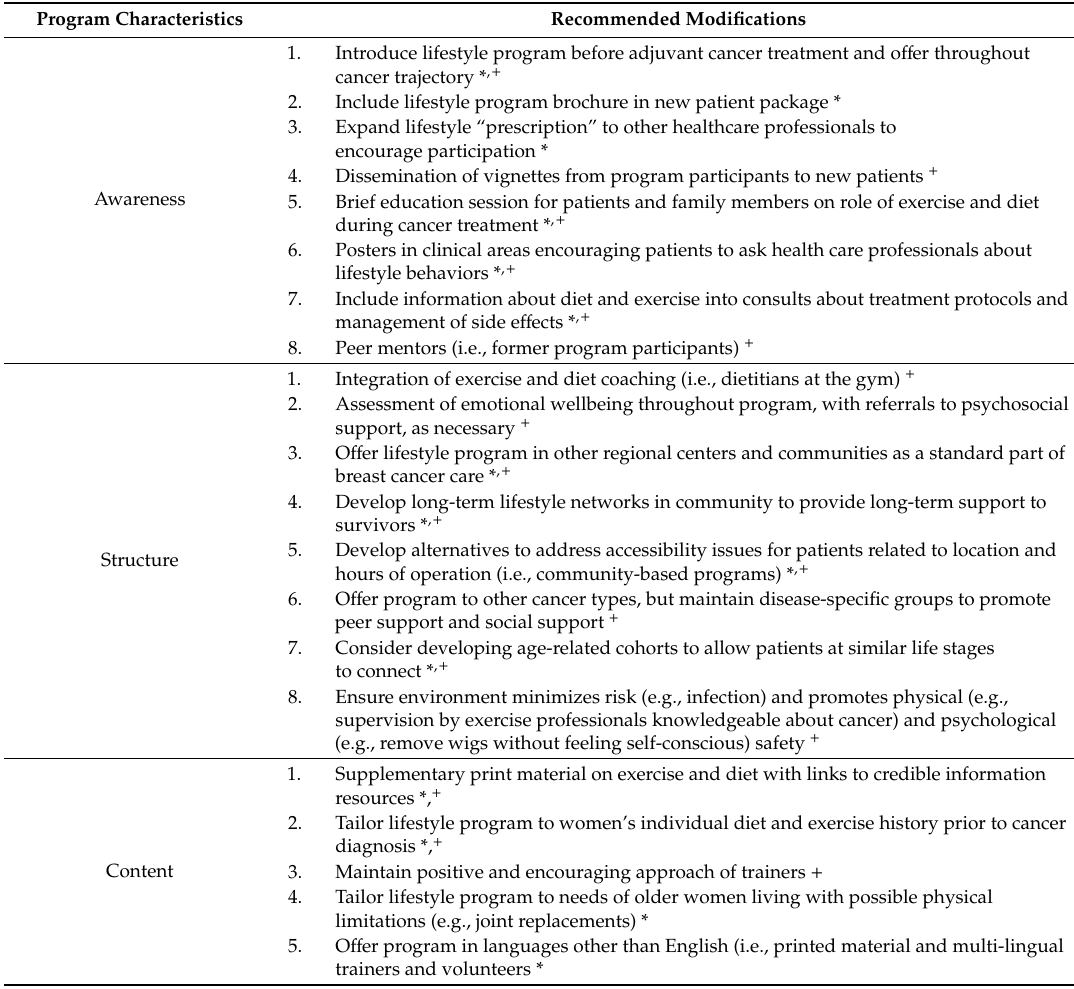
Table 3. Recommended Modifications to the Lifestyle Intervention